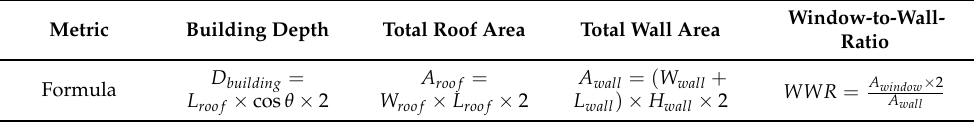
Table 1. The pipeline evaluation metrics formulae